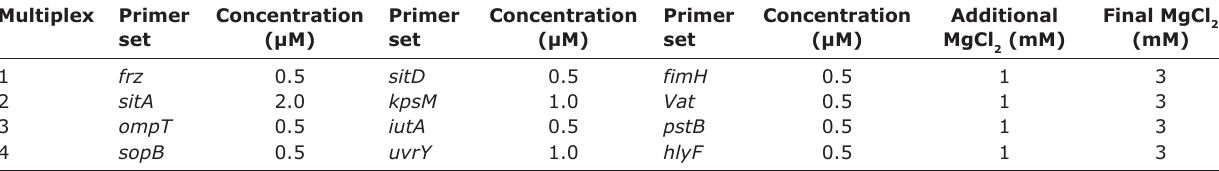
Table-S1: Final primer concentrations used in the different multiplex